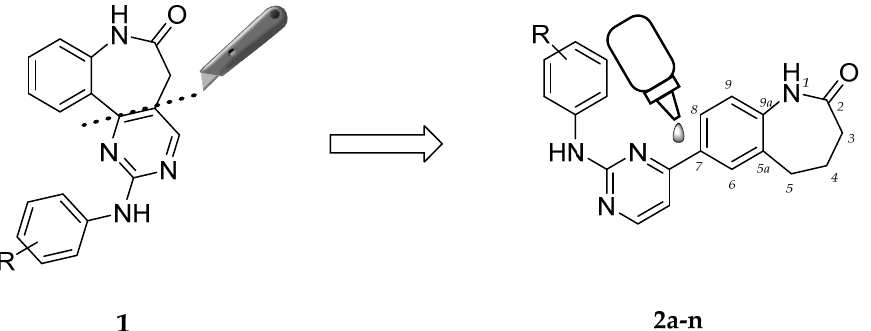
Figure 1. “Cut and glue” strategy: the 1-benzazepin-2-one and the anilinopyrimidine parts of the PLK-inhibitor scaffold 1 were detached at the annulation site and reconnected at the 7- and the 4- positions of the ring systems, resulting in the title structures 2a – n . For residues R refer to Table 3.